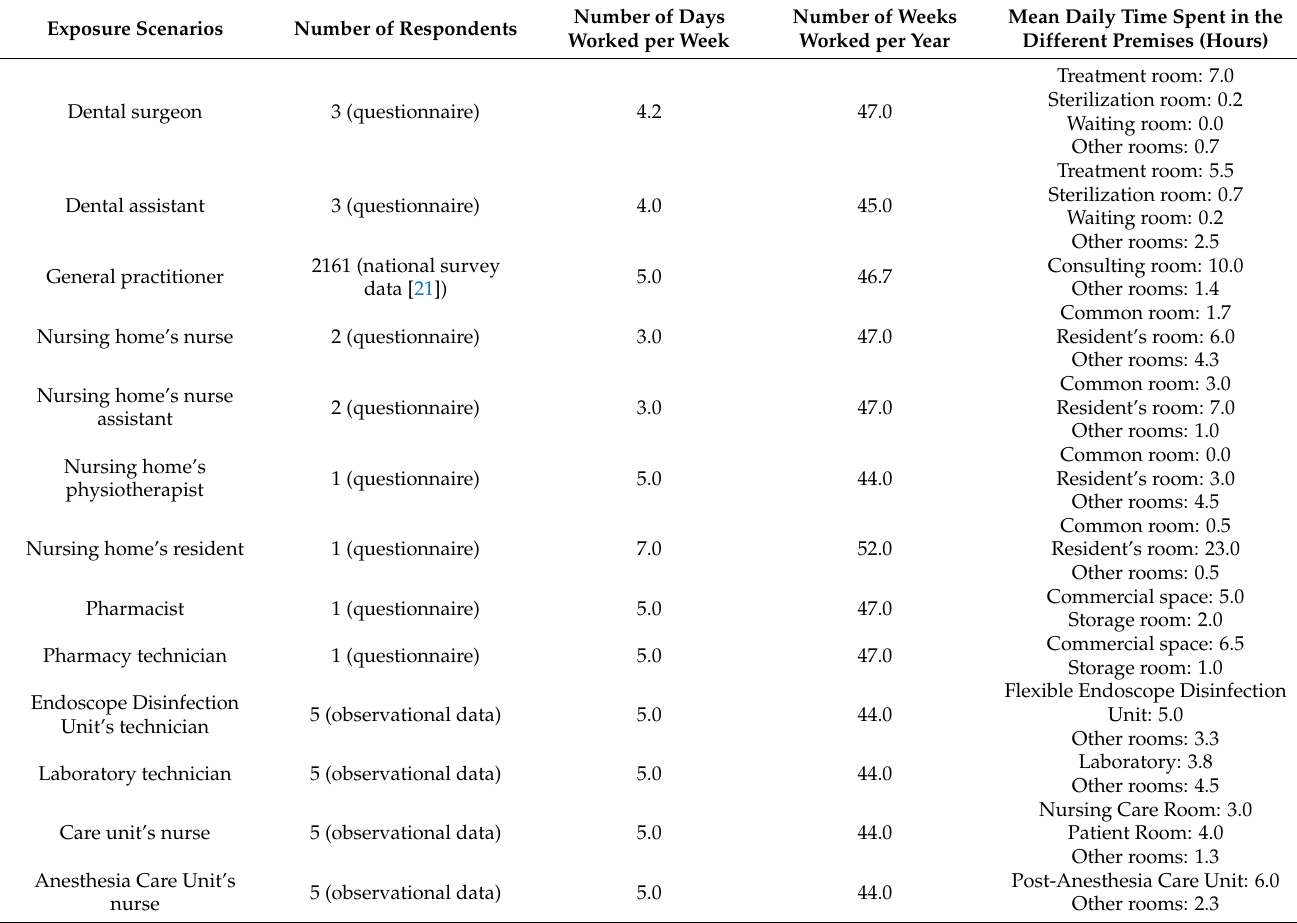
Table 3. Exposure